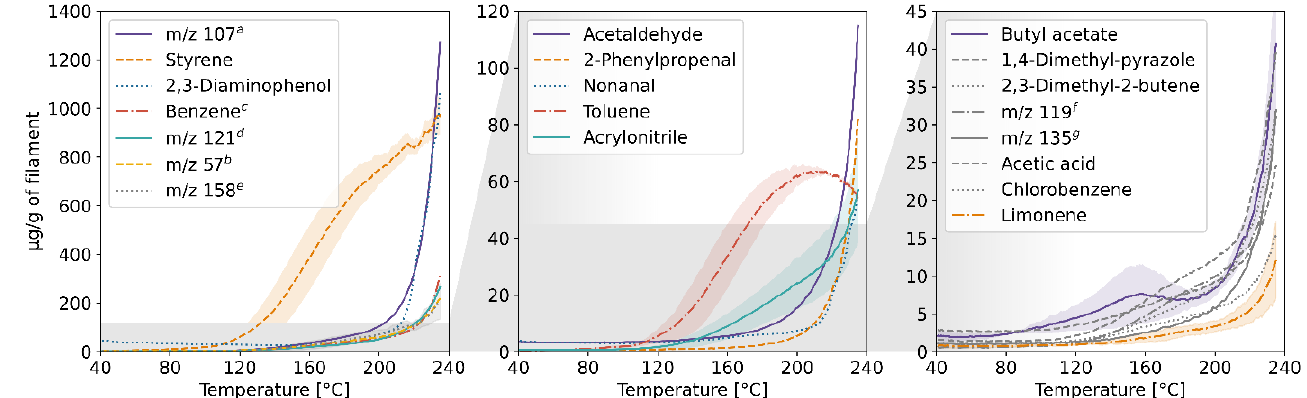
Figure 4. The mixing ratio of main VOCs within the enclosure during FFF 3D printing with the ASA